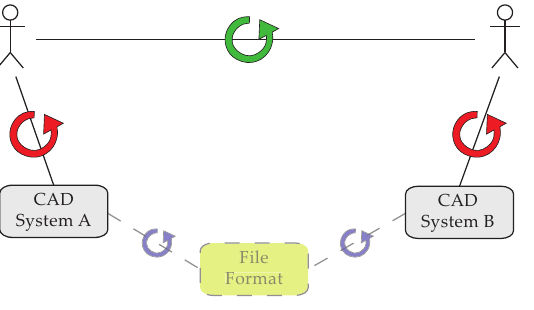
Figure 5. In the remodelling effort strategy, information is primarily exchanged between users, possibly with additional reliance on file exchange mechanisms. Interface points (circular arrows) are points where information is interpreted from one information structure into the other. In this case, this happens mainly among people (in green), but support via information systems is possible (red and blue interface points).